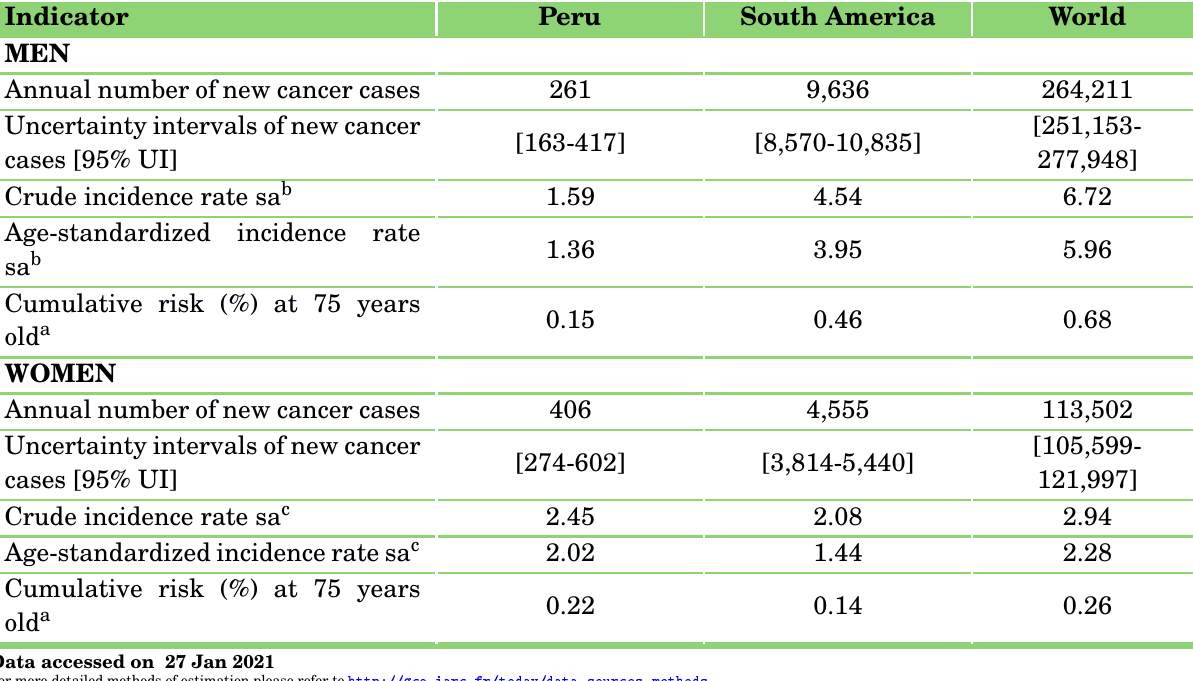
Table 17: Oral cavity cancer incidence in Peru (estimates for 2020)